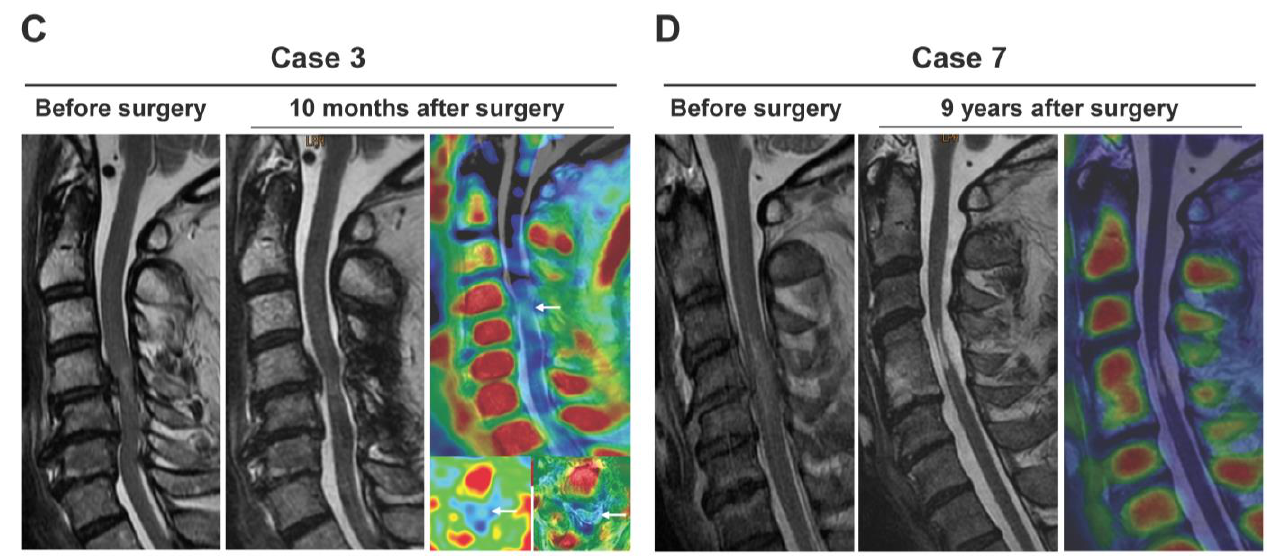
Figure 5. Clinical application of (R) -[ 11 C]PK11195 PET/3T-MRI for patients with neuropathic pain. Data are shown for a healthy subject ( A ) and in patients examined at 4 weeks ( B ), at 10 months ( C ), and 9 years ( D ) after surgery. (R) -[ 11 C]PK11195 uptake was apparent at 4 weeks and 10 months, but there was no significant (R) -[ 11 C]PK11195 uptake at 9 years, despite the patient having severe neuropathic pain.